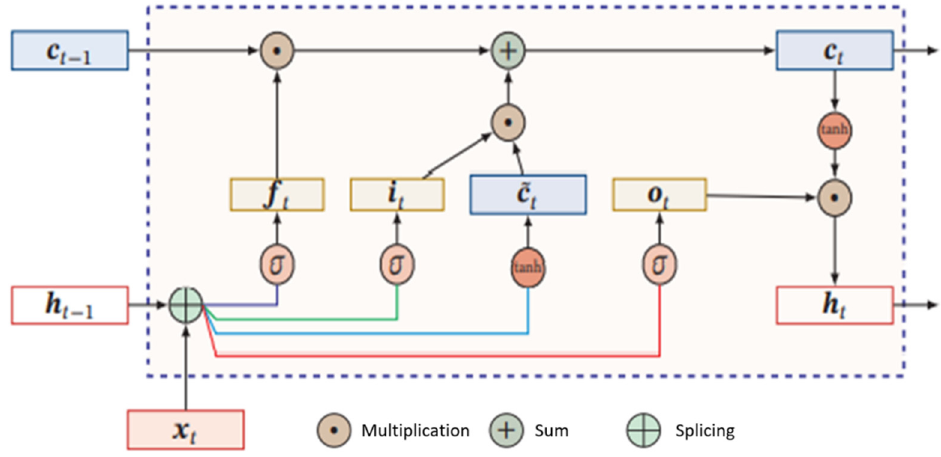
Figure 8. Cycle cell structure of LSTM [72].